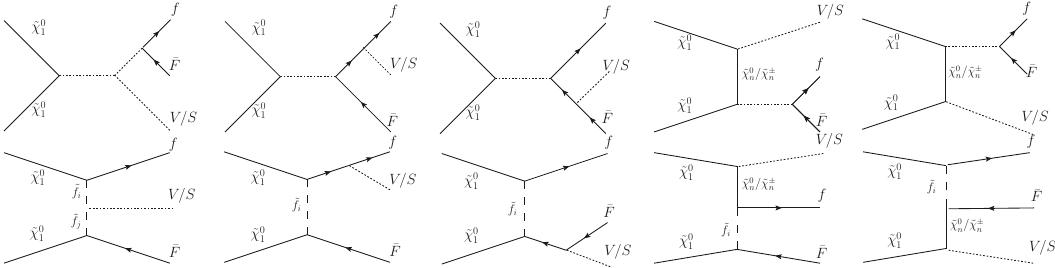
Figure 1 . Condensed representation of all Feynman diagrams for neutralino annihilation into (cid:22) FfV or (cid:22) FfS , where dotted lines indicate scalar ( S = A; h; H; H (cid:6) ) or vector ( V = Z; W (cid:6) ) mediators, depending on the (cid:12)nal state con(cid:12)guration. Fermion (cid:12)nal states are identical, F = f , for neutral boson emission ( h , H , A or Z ), while ( f; F ) constitute the two components of an SU(2) L doublet for charged boson emission ( H (cid:6) or W (cid:6) ). See text for more details on how the individual topologies are referred to in this